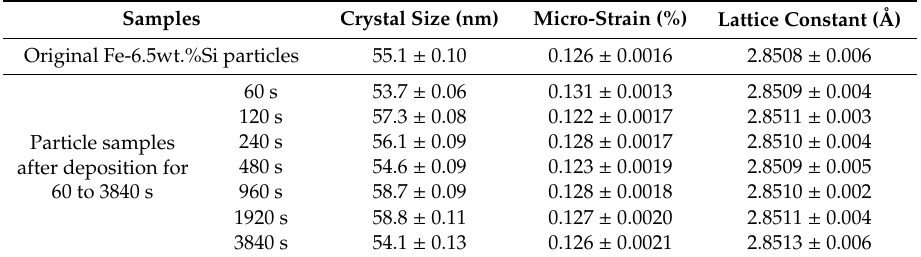
Table 1. The average crystal sizes, micro-strains, and lattice constants of α -Fe(Si) in the original Fe-6.5wt.%Si particles and the particles obtained after fluidized bed chemical vapor deposition